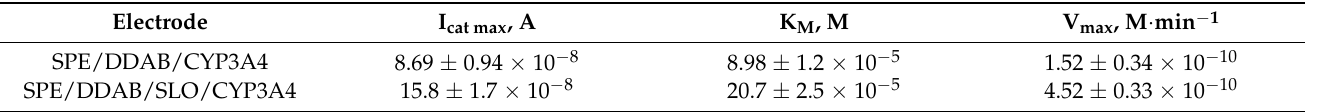
Table 3. Efficiency of erythromycin electrocatalytic CYP3A4-dependent N-demethylation at the defined potential of − 0.5 V for a duration of 20 min.